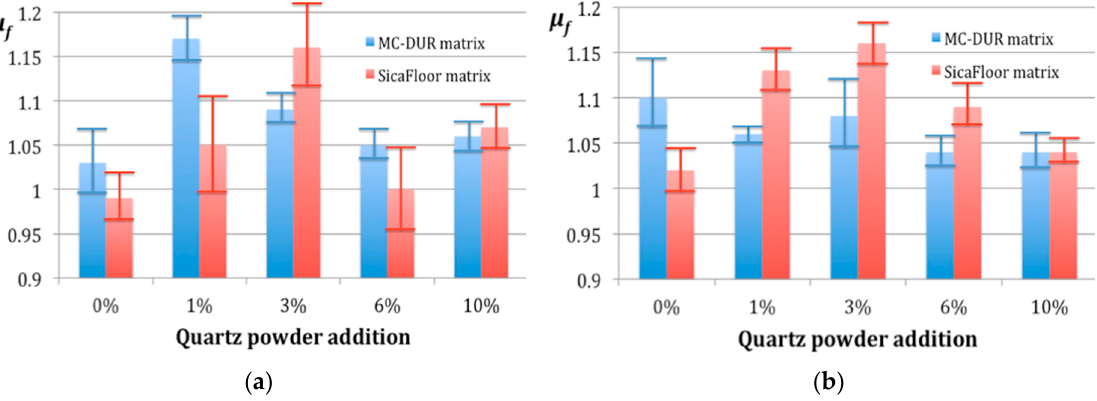
Figure 4. The average values of the friction coefficient μ f dependent on the particulate filler proportions for the composites with the polymer matrices MC-DUR 1200VK and Sikafloor 156: ( a ) with the emulsion binder; ( b ) with the powder binder.